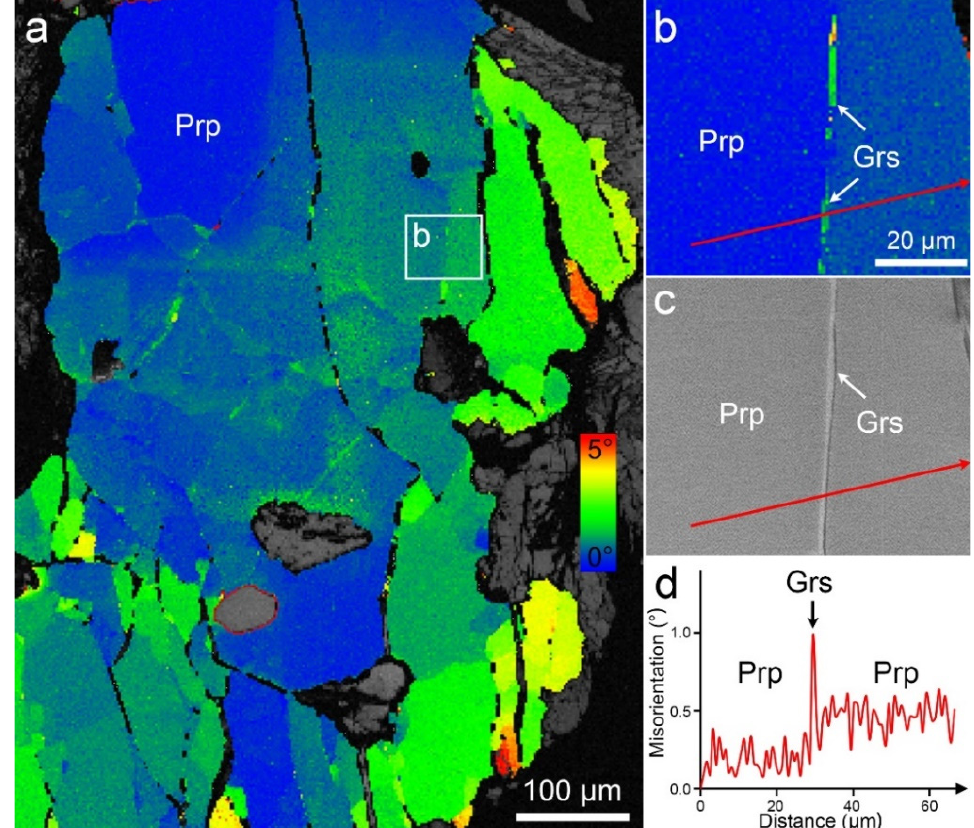
Figure 3. EBSD images of Grs-rich exsolutions precipitated at the subgrain boundaries of Prp-rich host. ( a ) Texture component map shows the elongated pyrope-rich host grain containing numerous subgrains with small misorientation angles ( ≤ 5°). ( b , c ) Detailed texture component map and its corresponding BSE image of the outlined area in ( a ) show the Grs-rich exsolutions precipitated at the subgrain boundaries of Prp-rich host. ( d ) Misorientation profiles of the traverses marked by red lines in ( b ) and ( c ) show an increase in misorientation angle from the subdomain center toward subgrain margins and small misorientation angles (<3°) between the exsolutions and host.